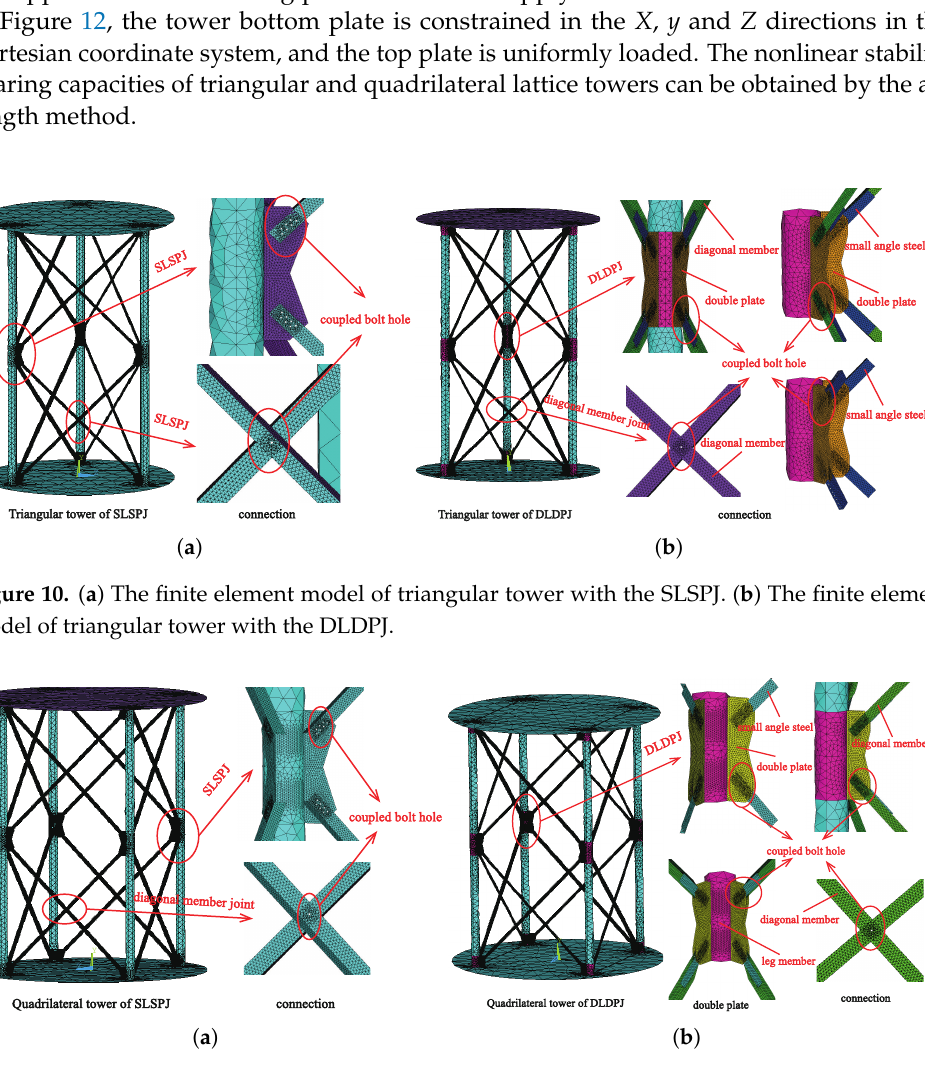
Figure 11. ( a ) The finite element model of quadrilateral tower with the SLSPJ. ( b ) The finite element model of quadrilateral tower with the